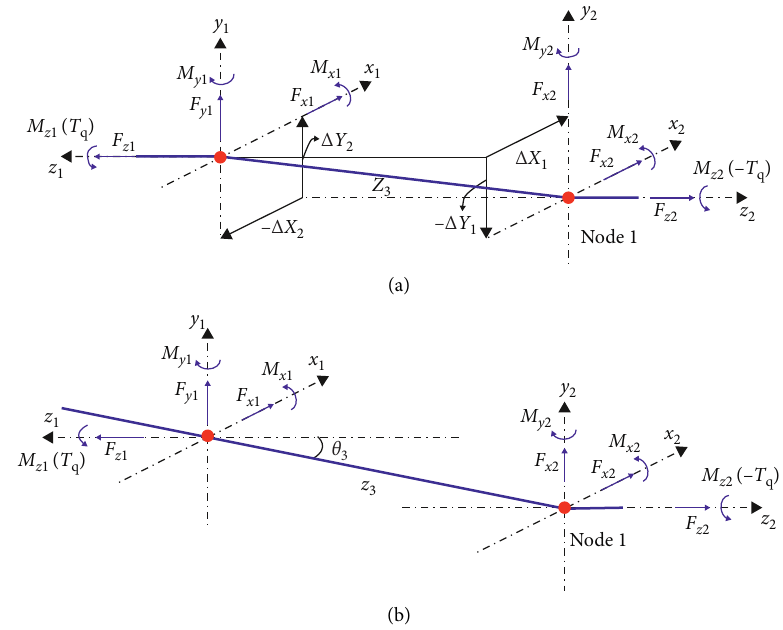
Figure 6: Coupling coordinate system: (a) parallel misalignment and (b) angular misalignment [31].